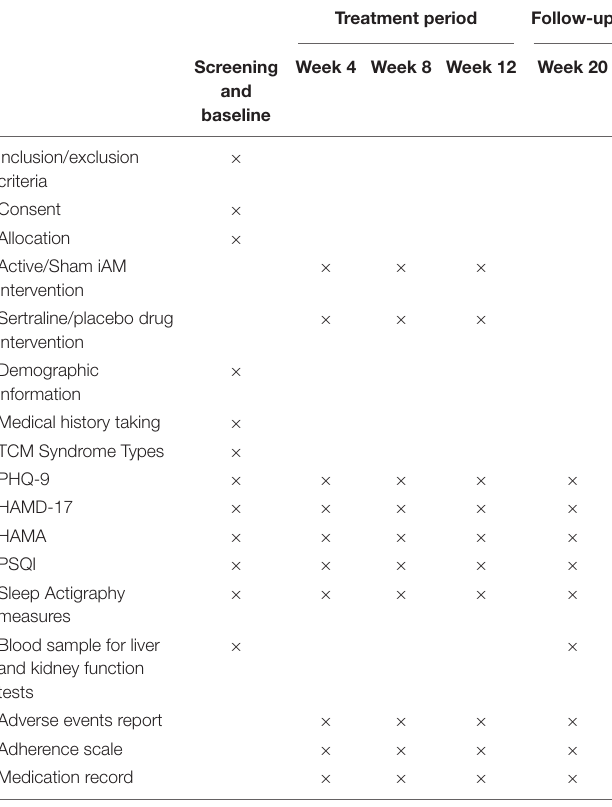
TABLE 2 | Schedule of study visits and assessments during the enrolment, treatment, and follow-up periods. Treatment period